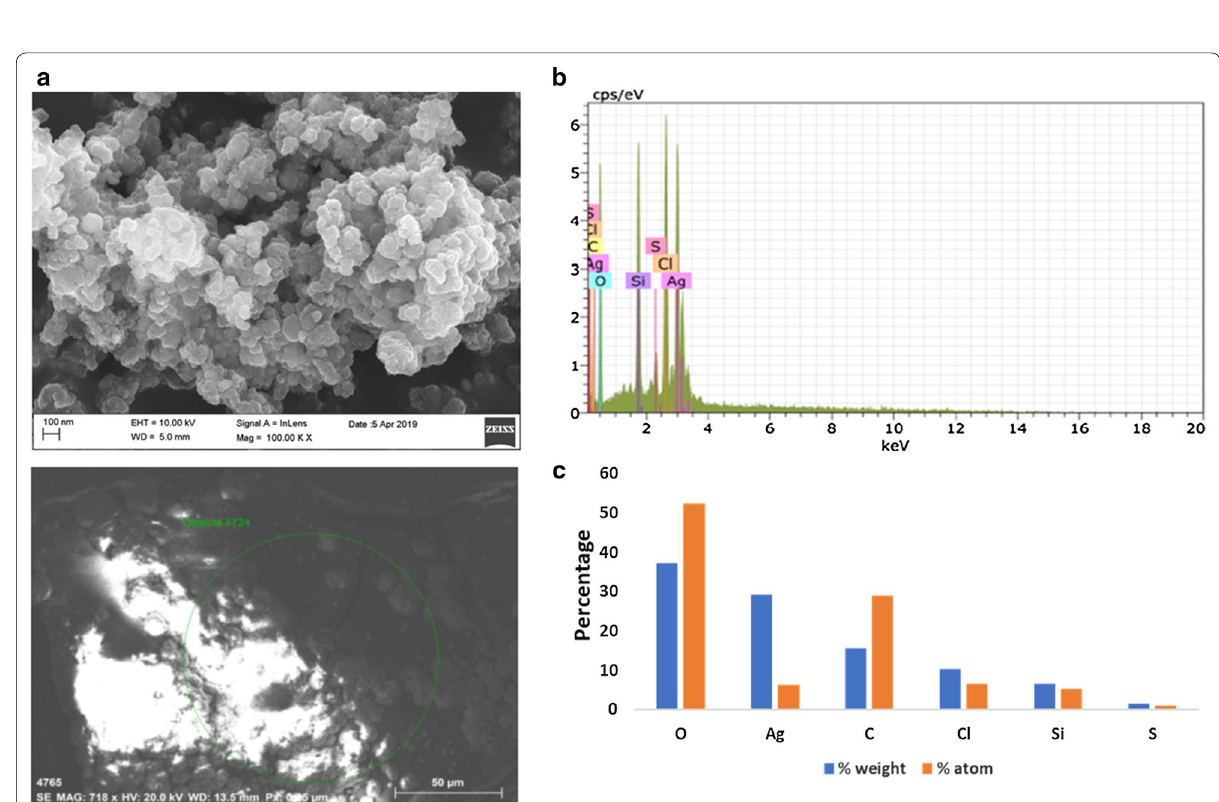
Fig. 3 a FESEM imaging of CANCs, b EDAX analysis of CANCs, c Percentage of distribution of atoms in